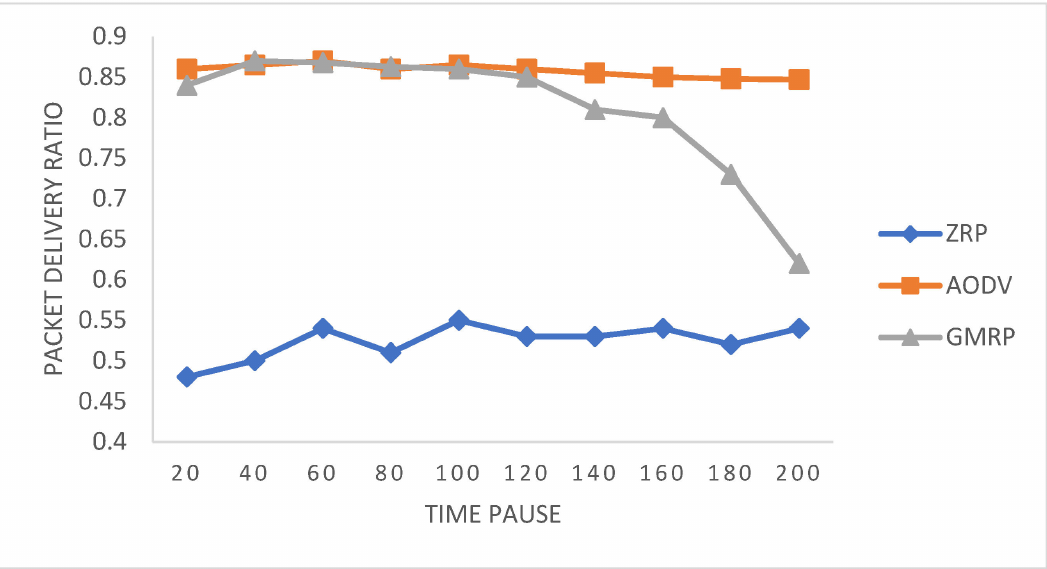
Figure 15. Packet delivery ratio (No. of packets received/No. of packets sent).